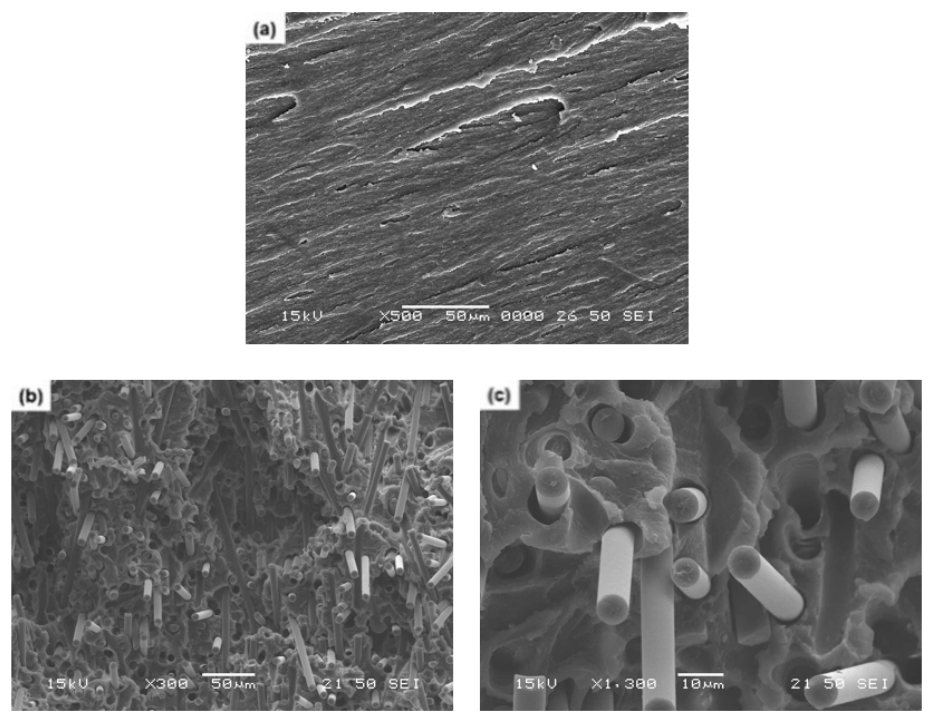
Figure 11. SEM micrographs ( a , b : ×500, c : ×1300) showing the fracture surfaces of ( a ) neat ABS and ( b , c ) carbon fiber/ABS composites with (epoxy) single-sized carbon fiber.